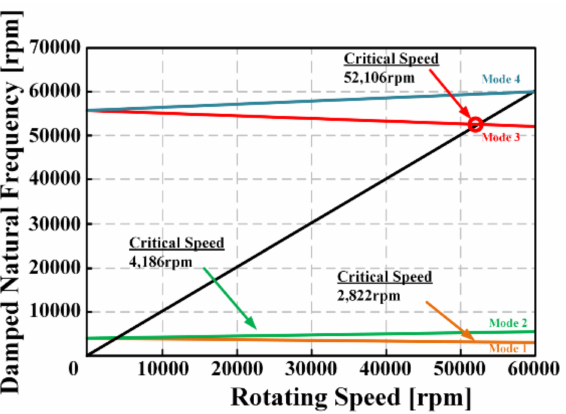
Figure 7. Critical speed analysis of Inconel 718 shaft rotor.